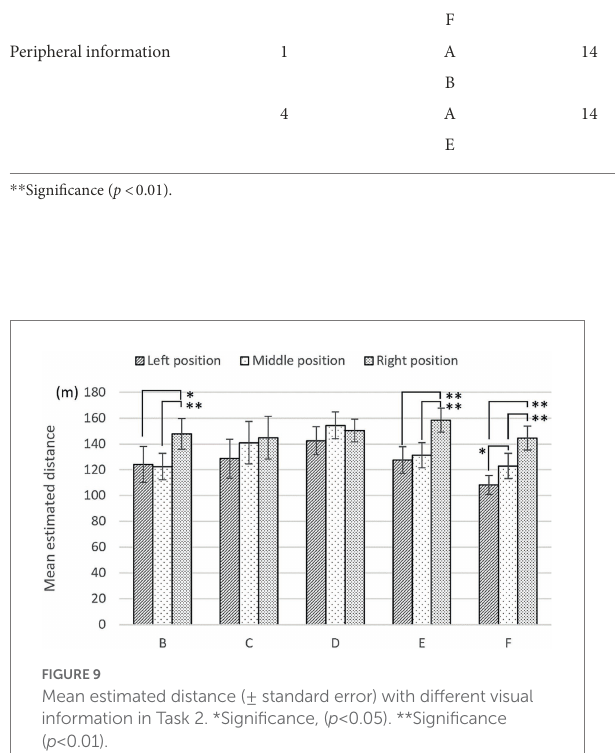
FIGURE 9 Mean estimated distance (± standard error) with different visual information in Task 2. *Significance, ( p < 0.05). **Significance ( p <